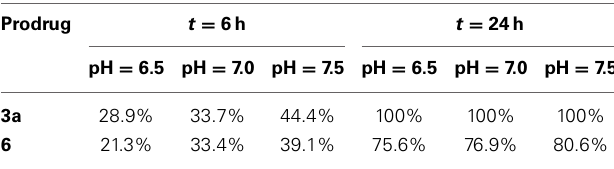
Table 1 | Influence of pH in the palladium-mediated dealkylation of compounds 3a and